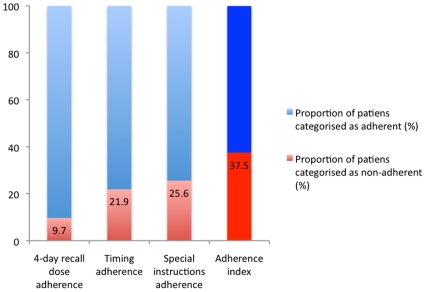
Different aspects of self-reported adherence at 6 months follow-up: 4-day recall dosing, timing, special instructions, and adherence index including all three aspects.
N = 352.